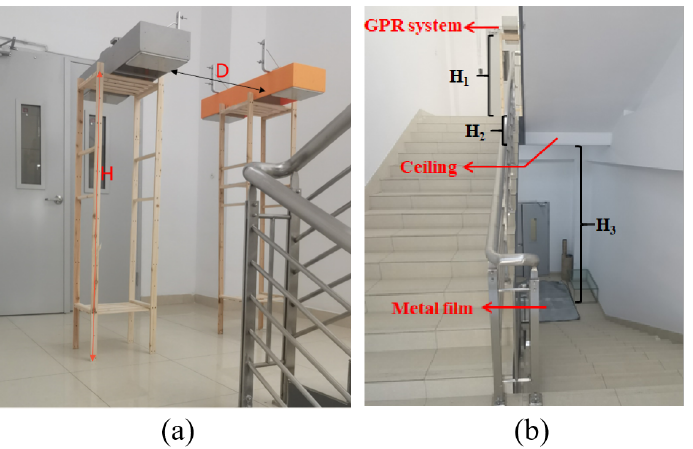
Figure 13. The static experiments are implemented to verify the penetration of the GPR transceiver frame. ( a ) The close-up photograph. ( b ) The full-scene photograph.